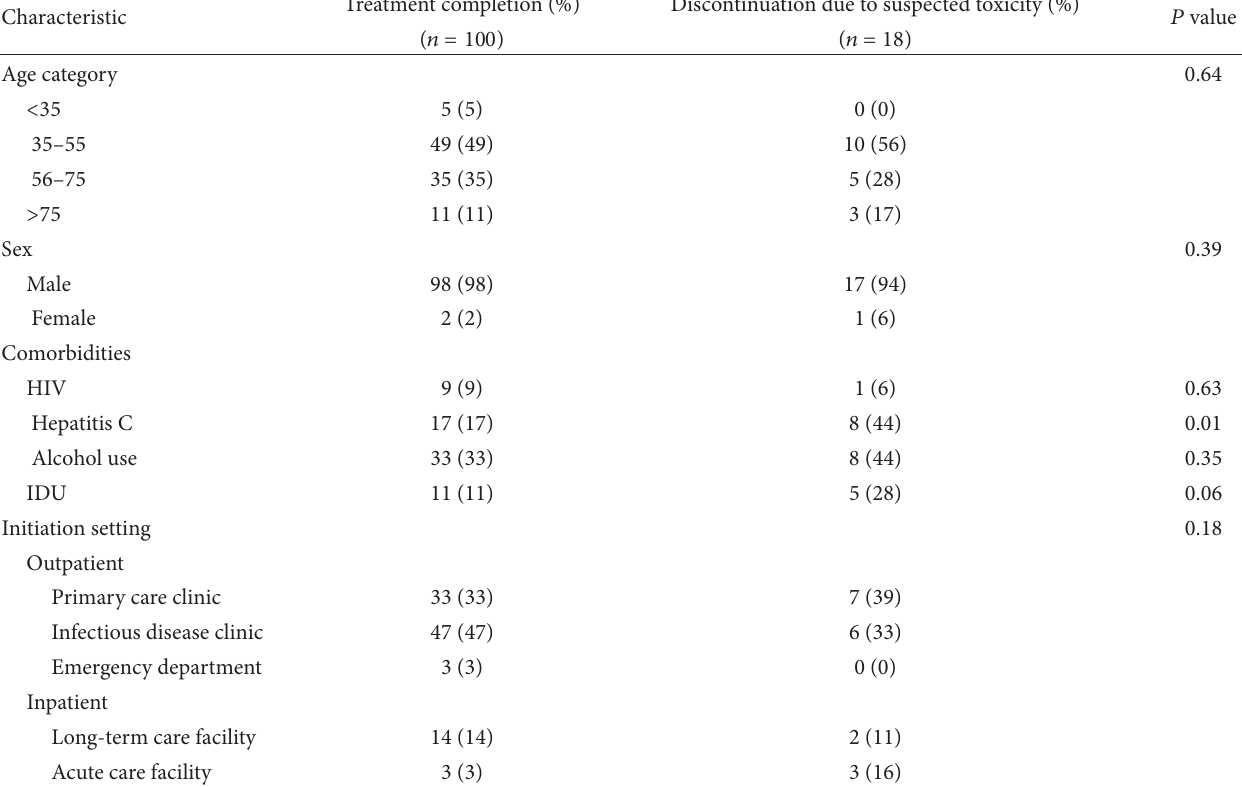
T 1: Characteristics of veterans with and without isoniazid discontinuation due to suspected